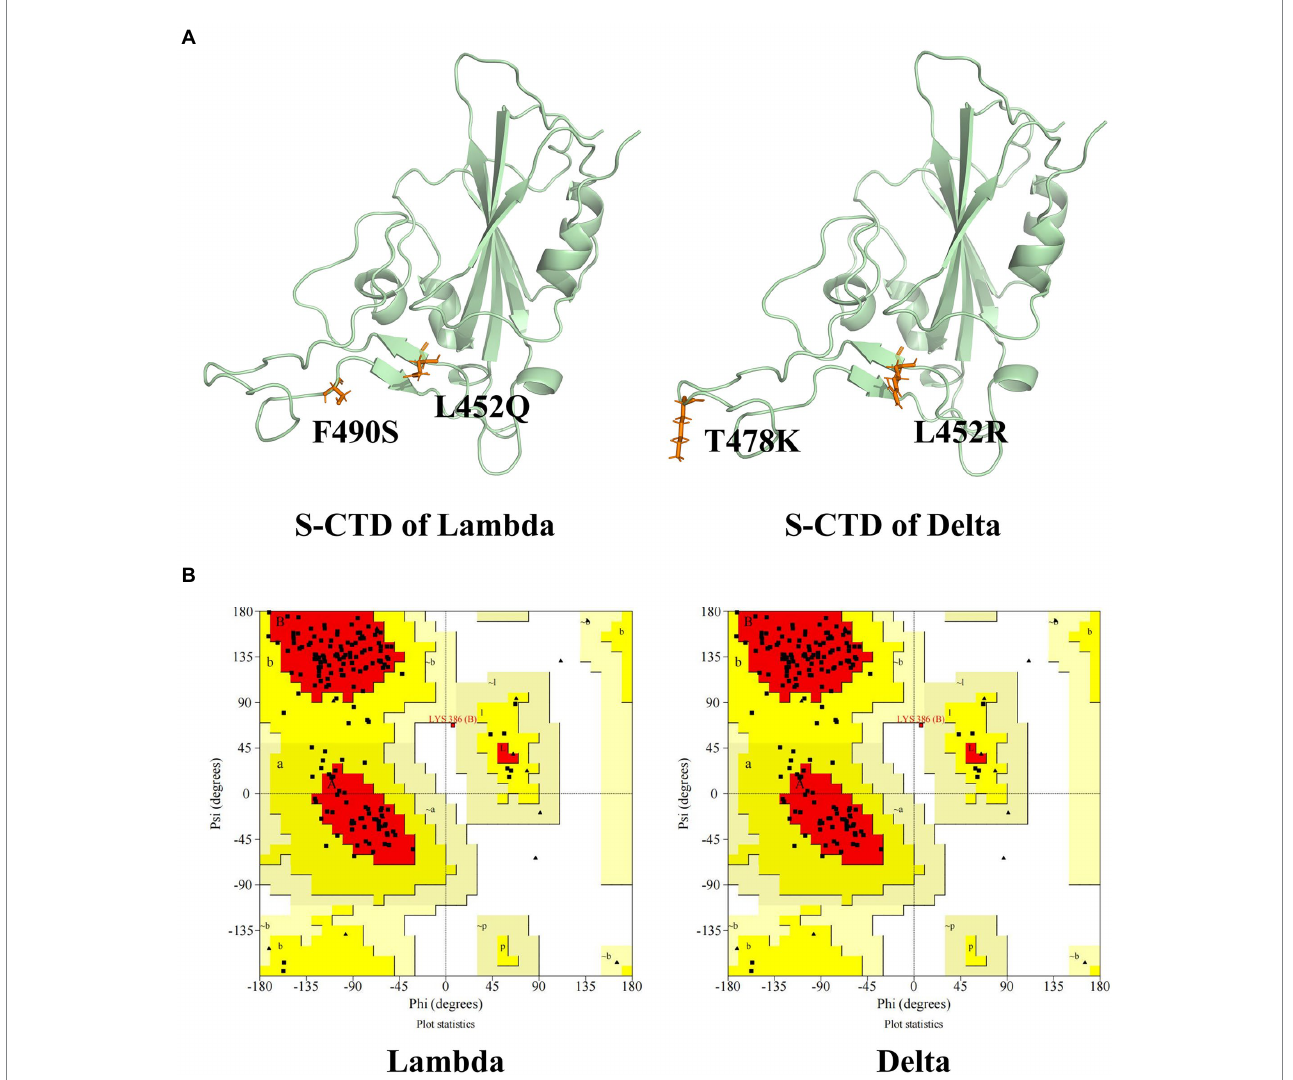
FIGURE 1 The CTD of S protein structure and evaluation. (A) The tertiary structure of CTD of S protein of Lambda and Delta strain. (B) The Ramachandran plot of the mutation S protein. The mutation residues were shown in orange and CTD of S protein was shown in palegreen.